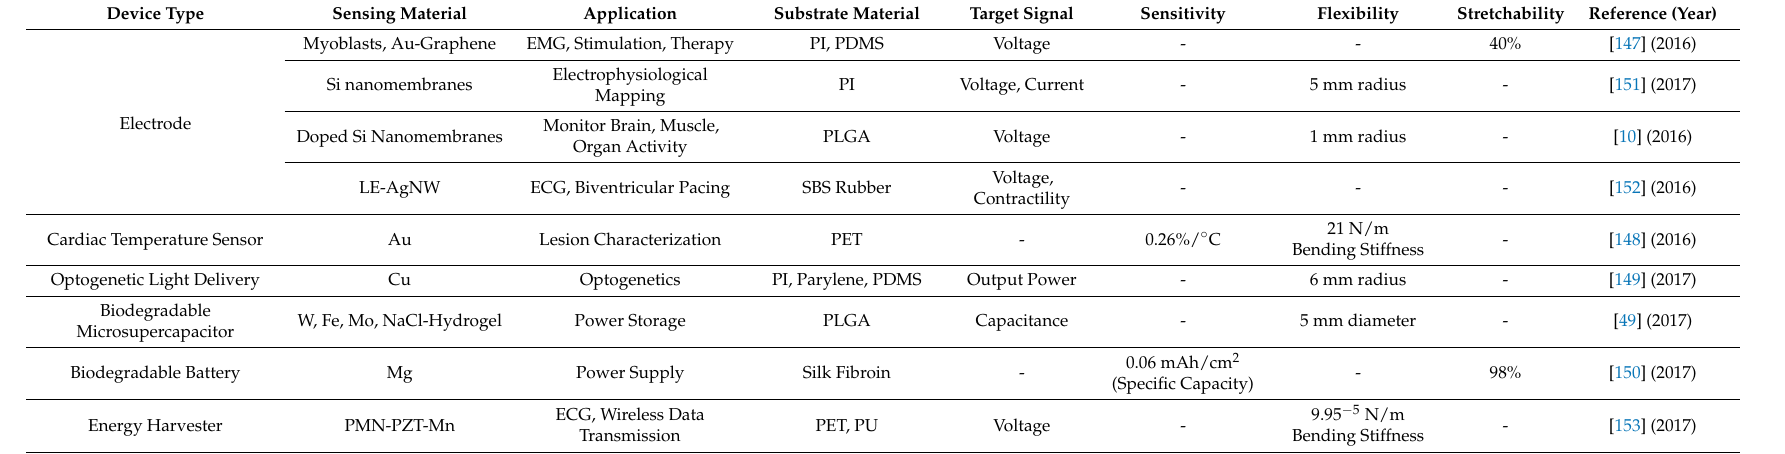
Table 4. Summary of implantable FHE, material characteristics, and